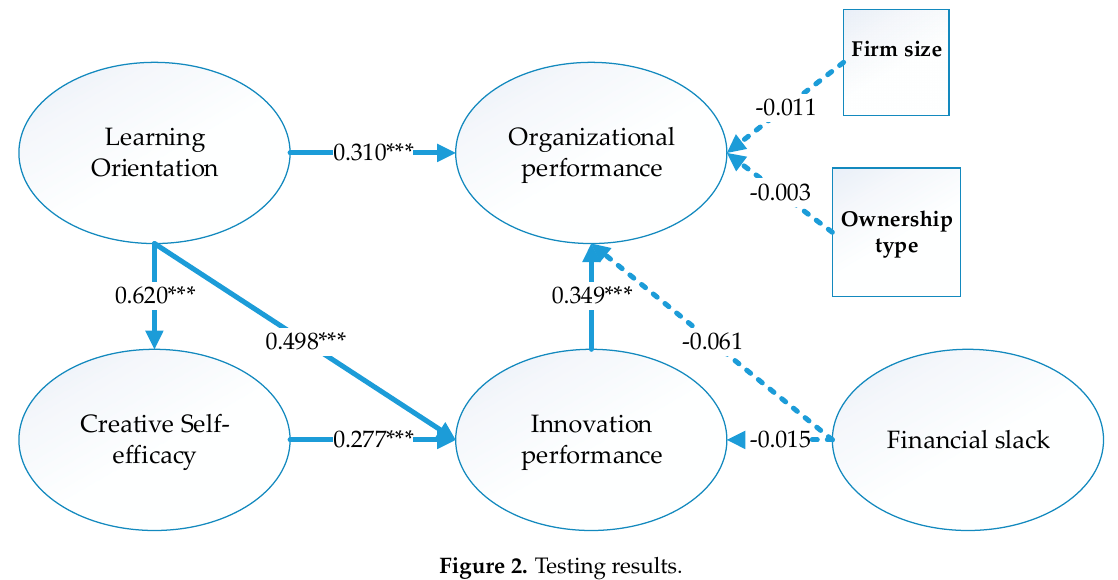
Figure 2. Testing results.